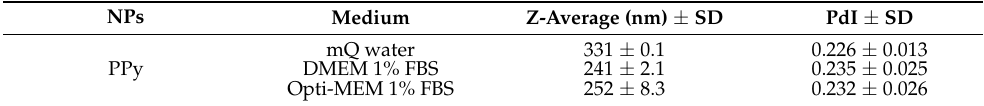
Figure 1. TEM images of PPy NPs. ( a ) PPy NPs aggregates (scale bar = 200 nm); ( b ) PPy NPs TEM images at higher magnification (scale bar = 100 nm). Table 1. Z-average (nm) and polydispersity index (PdI) of 100 µg/mL PPy NPs measured by dynamic light scattering (DLS) and in two different media (mQ water and culture media). Means ± SD of three replicates.